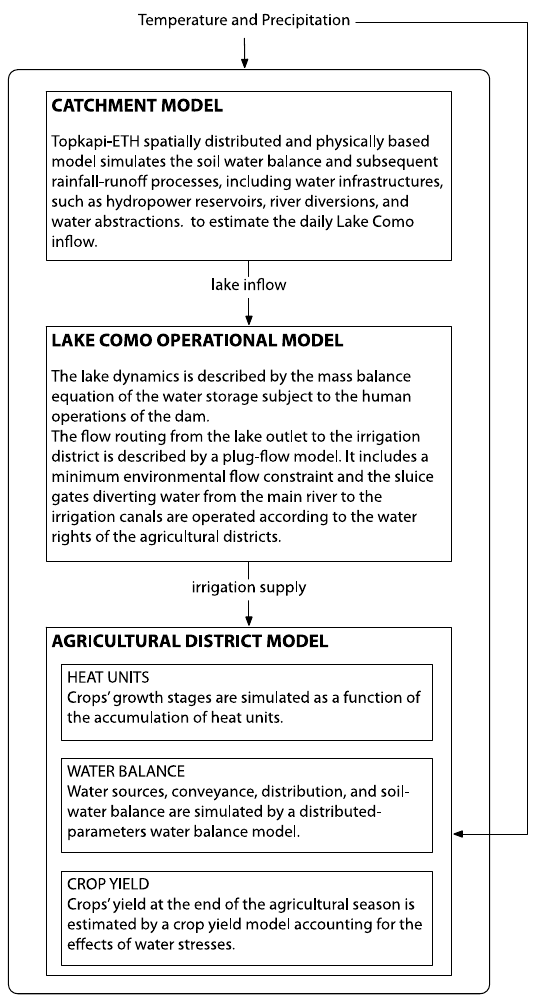
Figure B4. The Lake Como integrated model. Figure A4. The Lake Como integrated